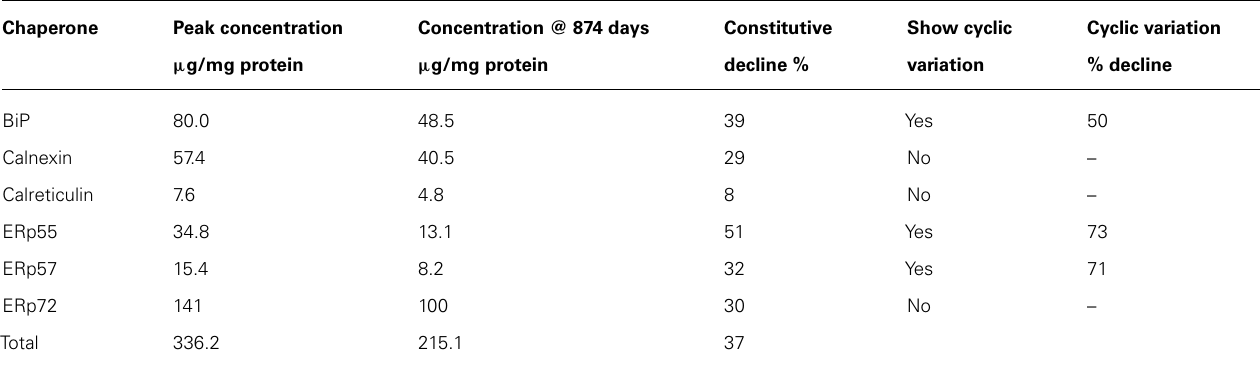
regions of the DNA and histone modifications play major roles in controlling both transcription and translation of proteins. Hence, potentially the most fruitful approach for high-throughput drug screening would be to develop cell models in which compact flu- orescent proteins, such as green fluorescent protein (GFP), are embedded in an exon of the otherwise intact target gene. This should maximize the number of potential target sites for small molecule, drug discovery. Such transgenic models are created in embryonic or induced pluripotent stem cells by homologous recombination using a variety of site specific endonuclease systems. These models are